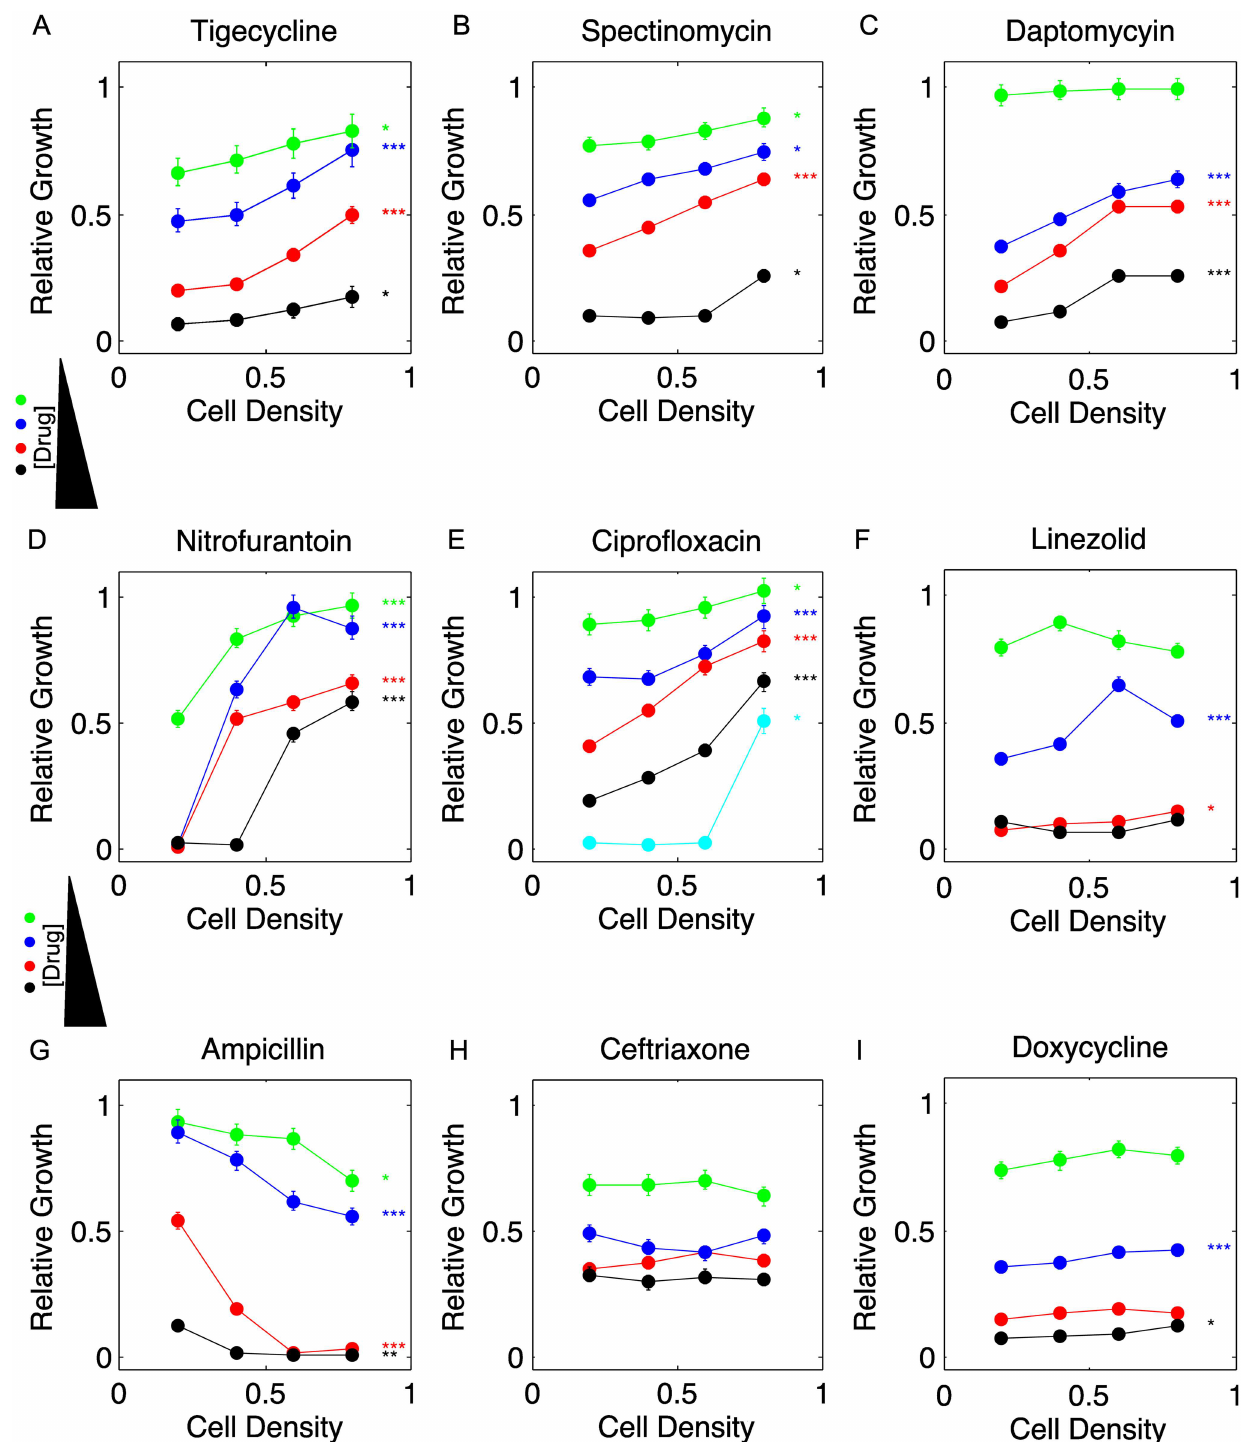
Fig 2. Cell density modulates the inhibitory effects of multiple antibiotics. A-I: Steady state populationgrowth rate (relative to untreated cells) as a function of cell density for multiple drug concentrations. Drug concentrations are A. Tigecyclineconcentration = 15 (green), 25 (blue), 50 (red), 100 (black) ng/mL; B. Spectinomycin concentration = 50 (green), 100 (blue), 150 (red), 400 (black) μ g/mL; C. Daptomycin concentration = 1.0 (green), 1.25 (blue), 1.50 (red), 3.0 (black) μ g/mL; D. Nitrofurantoin concentration = 50 (green), 100 (blue), 125 (red), 250 (black) μ g/mL; E. Ciprofloxacin concentration = 100 (green), 150 (blue), 200 (red), 300 (black), 400 (cyan) ng/mL; F.